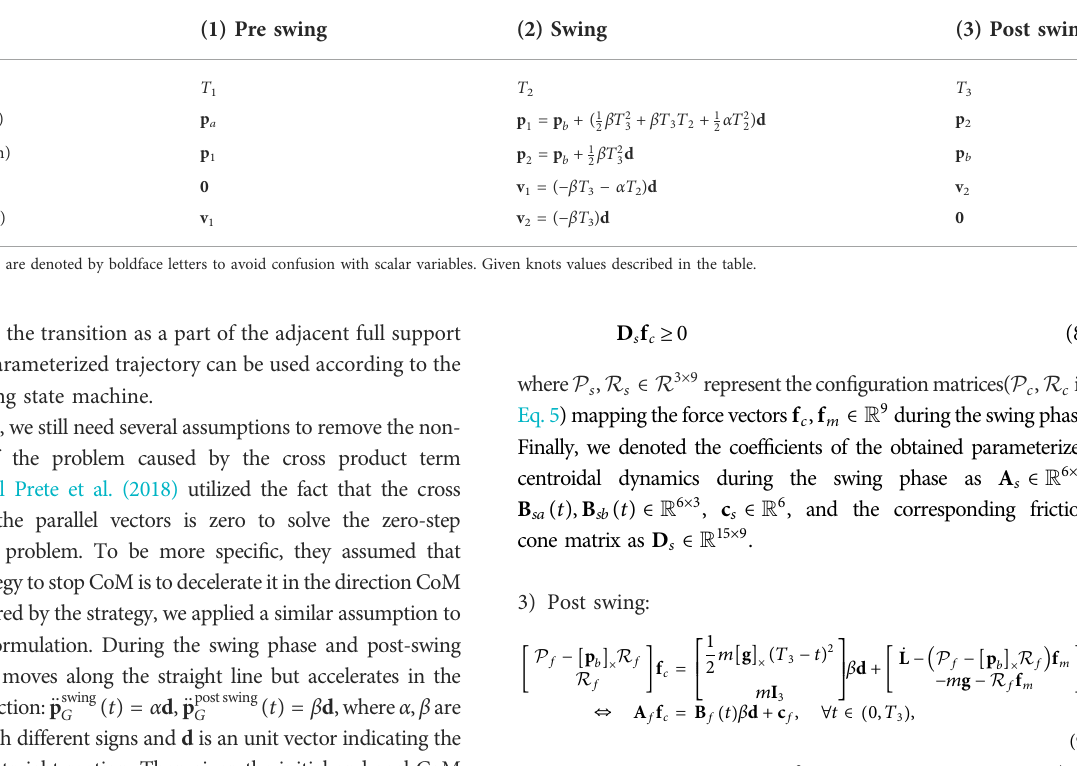
TABLE 1 Summary of phase-based CoM trajectory parameterization for one-step climbing motion. Given knots values described in the table, CoM trajectory can be computed via cubic Hermite polynomial (p HS ( t ; T , p i , p g , v i , v g )). Detailed equations are described in